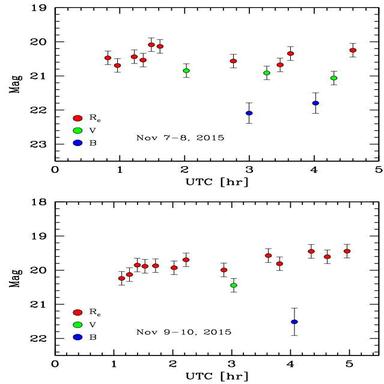
The WT1190F B; V ; R lightcurve along the Loiano observing runs of 2015 November 7–8 and November 9–10. The x-axis timeline refers to the UTC hours respectively of Nov 8 and Nov 10.